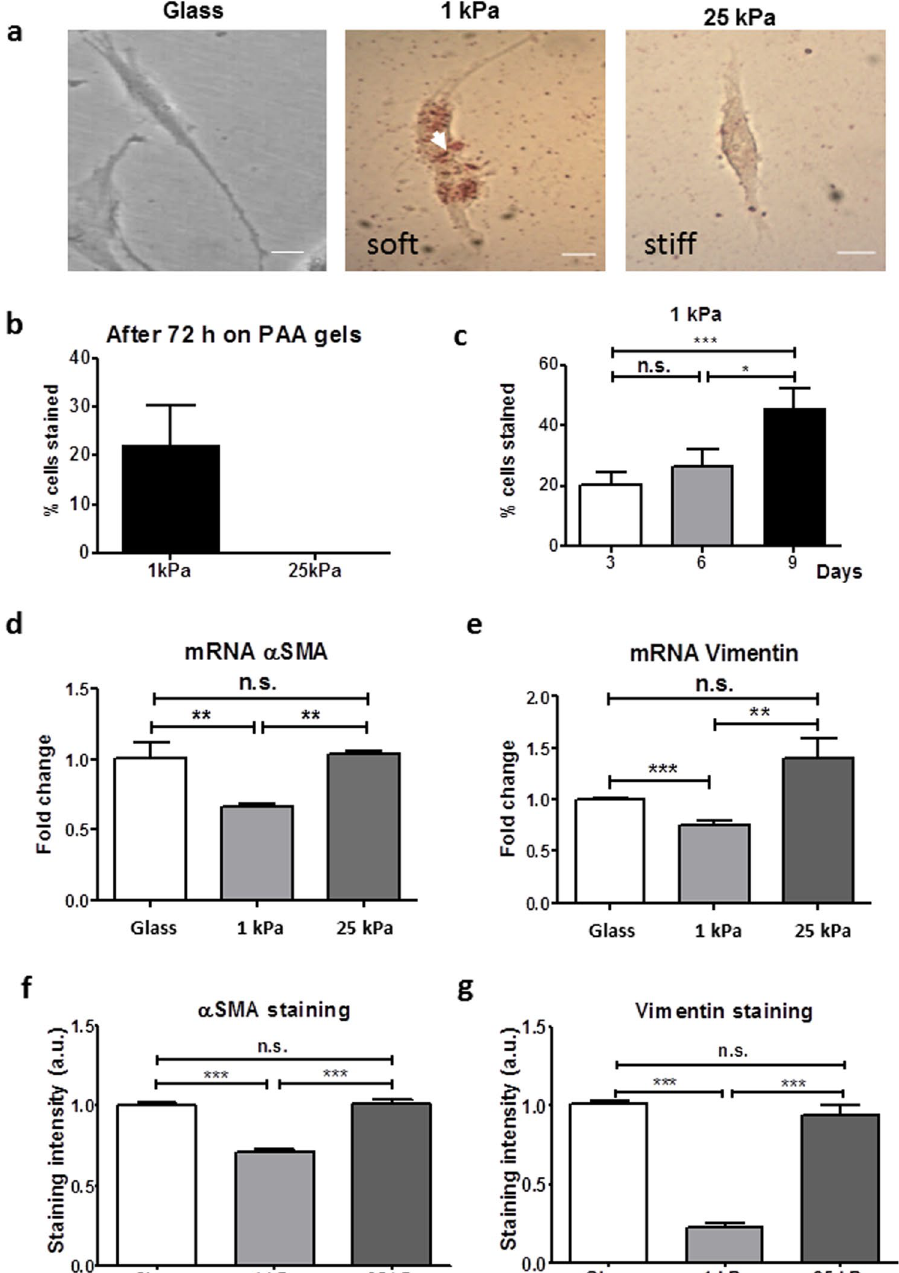
Figure 2. Soft matrices induce PSC deactivation. ( a ) Bright-field images of Oil Red O stained PSCs on glass, soft and stiff matrices for 6 days. Scale bar 25 μ m. ( b ) Cell population Oil Red staining levels after 3 days on soft or stiff PAA matrices show that active PSCs on soft matrix begin to revert back to quiescence. Representative of 3 independent experiments with 33 cells analysed. ( c ) Cell population Oil Red O staining levels after 3, 6 and 9 days on soft matrix confirm that culture of active PSCs on soft matrices reverts cells back into a resting state in a time-dependent manner. ( d , e ) pPCR mRNA levels of aSMA and vimentin for conditions represented in ( a ). ( f , g ) Quantification of staining intensity for α SMA and vimentin for conditions represented in ( a ), images in Supplementary Fig. 5. In all cases, histogram bars represent mean ± SEM. Data are representative of 3 independent experiments and 221 cells analysed in ( c ), * p < 0.05, ** p < 0.01, *** p < 0.001, n.s.